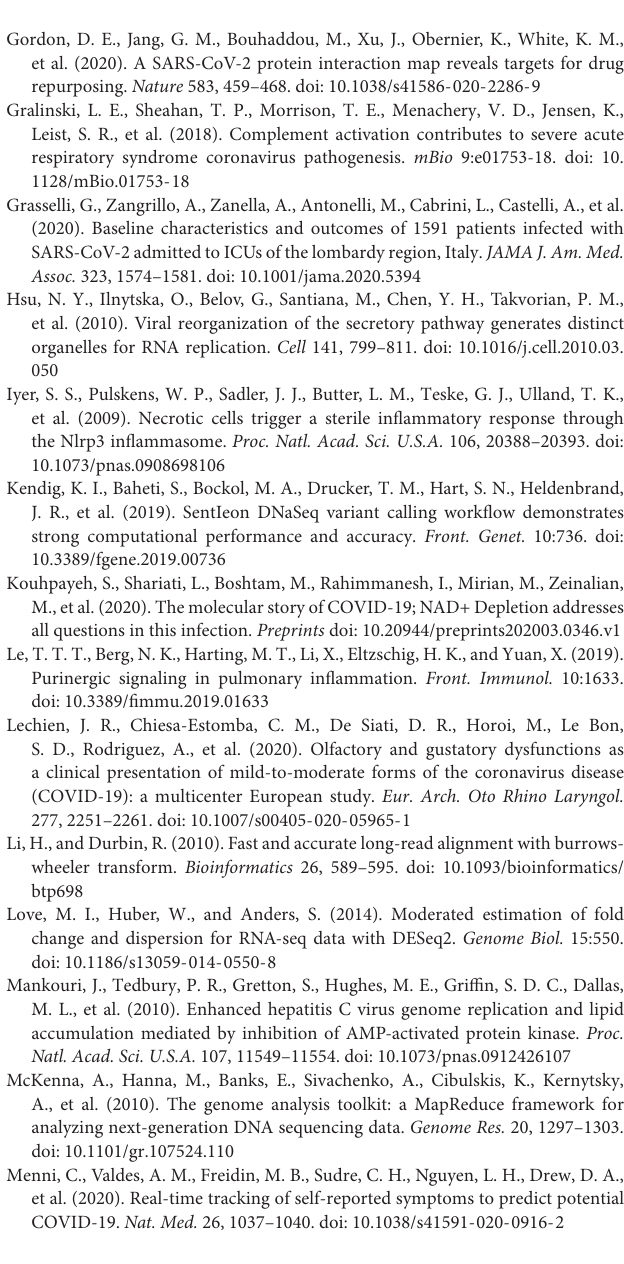
Supplementary Figure 1 | Illustration of timelines for the mild and severe cases. Supplementary Figure 2 | Summary of identified up- (A) and downregulated (B) genes in plasma of severe patient from HN sample set, blood cells of COVID-19 patients, and lung cells with SARS-CoV-2 infection. Supplementary Figure 3 | Summary of identified up- (A) and downregulated (B) genes in plasma of severe patients from WH sample set, blood cells of COVID-19 patients, and lung cells with SARS-CoV-2 infection. Supplementary Figure 4 | Enriched pathways of genes with consistent alteration of gene expressions in both plasma and tissues in the WH sample set. Enriched pathways of genes with consistent down- (A) and upregulated pattern (B) in plasma of severe patient and blood cells of COVID-19 patients. Enriched pathways of genes with consistent down- (C) and upregulated